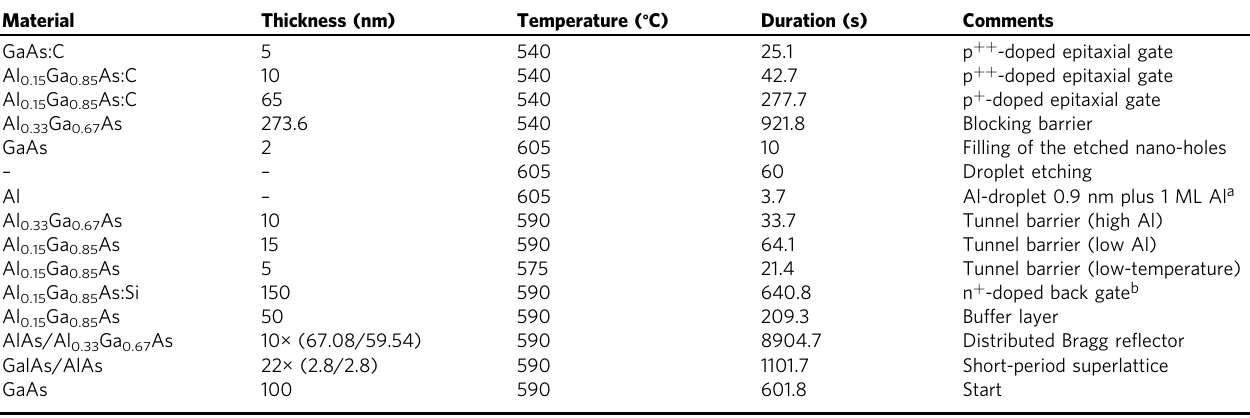
Table 1 Sample design with relevant growth parameters.